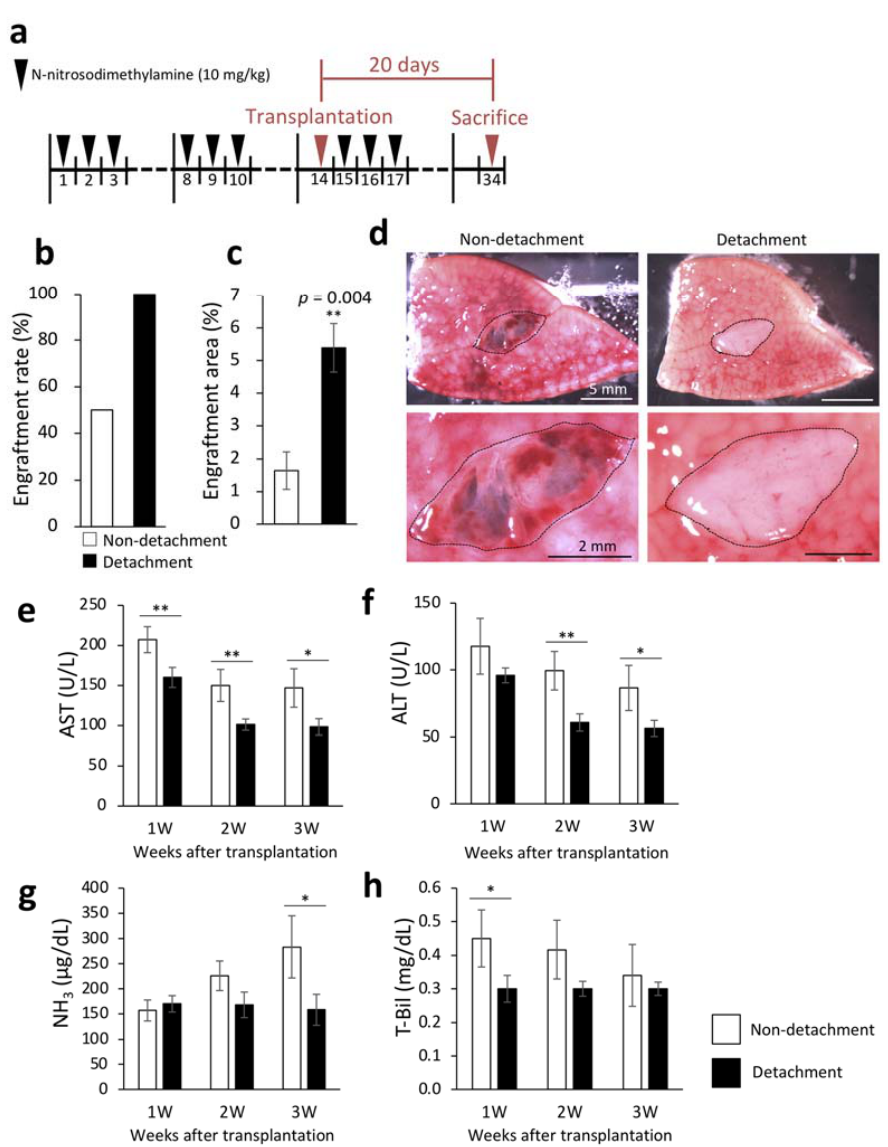
Figure 1. Engraftment efficiency of the fetal liver and evaluation of liver function following serous membrane detachment in the DMN-induced liver cirrhosis rat model. ( a ) The procedure for producing rat model of liver cirrhosis. Livers were collected 20 days after transplantation. ( b ) At three weeks after transplantation, fetal liver engraftment rate was determined in the non-detachment ( n = 6) and detachment ( n = 7) groups. ( c ) Livers were removed three weeks after transplantation, and frozen sections were stained for dipeptidyl peptidase IV (DPPIV). Areas with DPPIV-positive staining were quantified using ImageJ (non-detachment, n = 6; detachment, n = 7). p = 0.004. ( d ) Fetal livers were transplanted between the left and middle lobes of rats, cut surface of the liver was observed three weeks after transplantation by microscopy. The area encircled by the black dotted line indicates the fetal liver. ( d – g ) Plasma concentrations of aspartate aminotransferase (AST) ( e ), alanine aminotransferase (ALT) ( f ), NH 3 ( g ), and total bilirubin (T-Bil) ( h ) in recipient rats were measured at 1–3 weeks after transplantation (non-detachment, n = 6; detachment, n = 7). The data are shown as the mean ± standard error. * p < 0.05, ** p < 0.01 versus non-detachment group by non-repeated measures analysis of variance with Bonferroni correction.